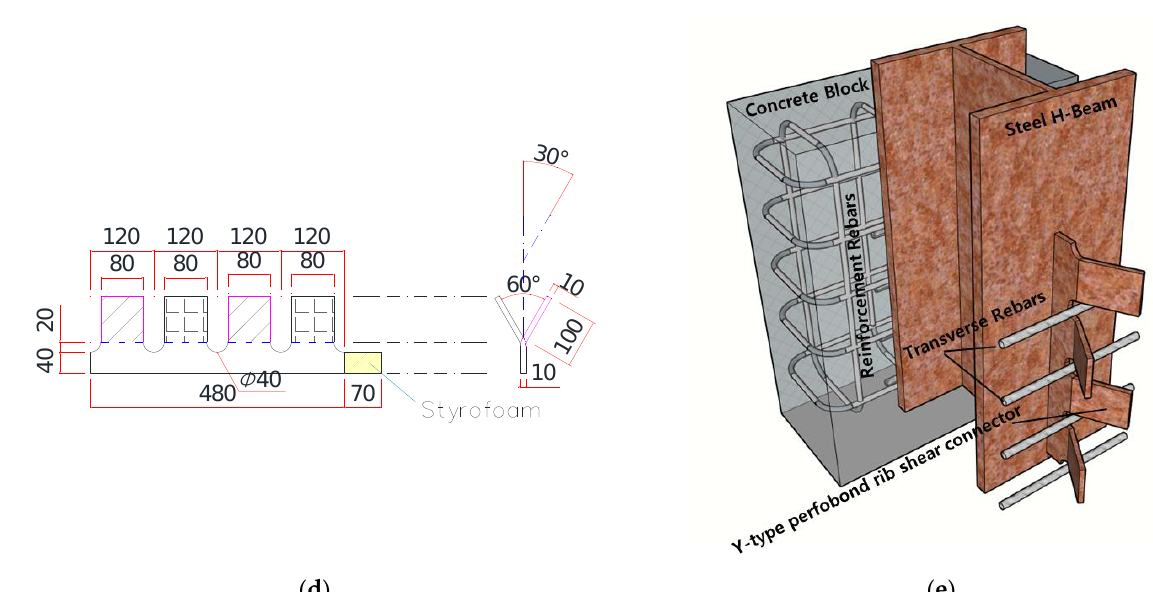
Figure 1. Dimensions of the push-out specimen with the Y-type perfobond rib shear connector (unit: mm). ( a ) Front view, ( b ) side view, ( c ) plan view, ( d ) Y-type perfobond rib shear connector and ( e ) push-out specimen with 3D.